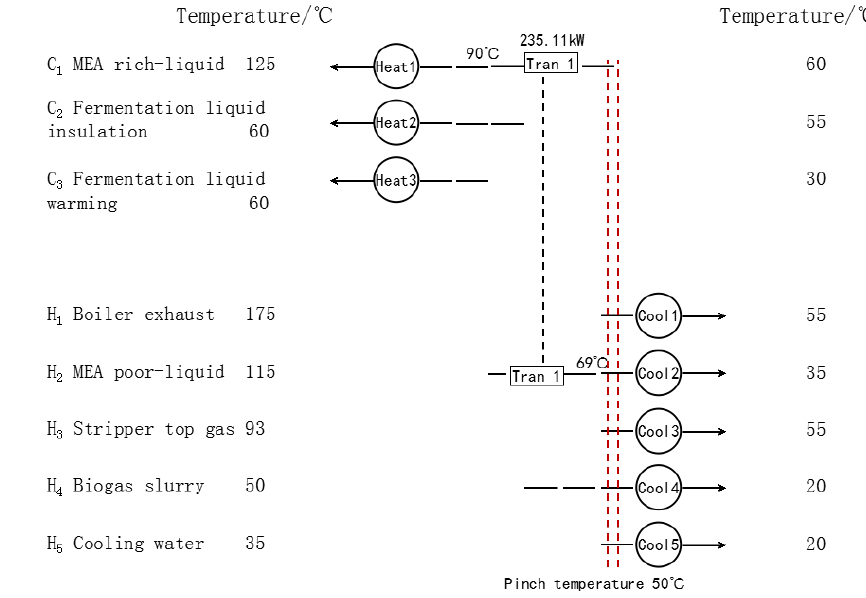
Figure 7. Grid diagram for the heat exchanger network.